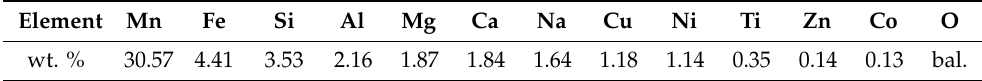
Table 1. Chemical composition (XRF) of the ground deep-sea nodules (wt. %) [29]. Element Mn Fe Si Al Mg Ca Na Cu Ni Ti Zn Co O wt. % 30.57 4.41 3.53 2.16 1.87 1.84 1.64 1.18 1.14 0.35 0.14 0.13